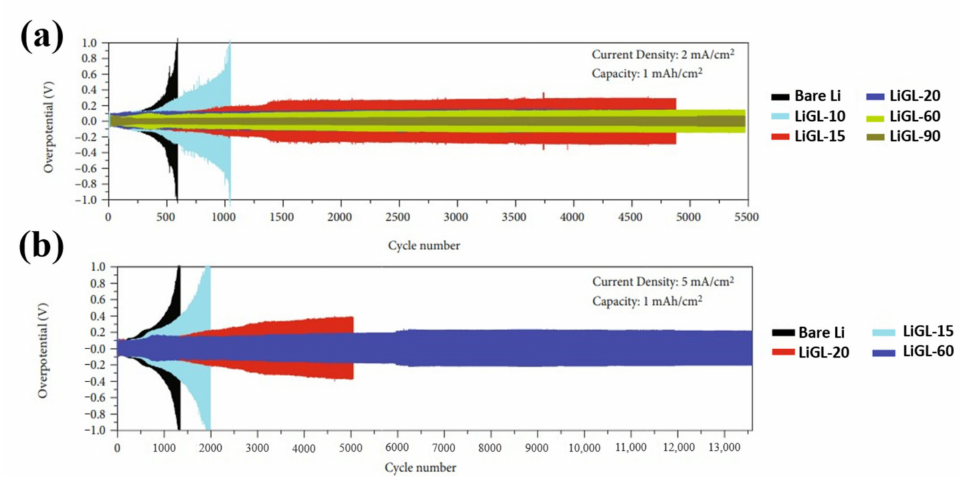
Figure 10. ( a ) Electrochemical stability of symmetric cells with bare and LiGL-coated Li in ether electrolyte at 2 mA cm − 2 and ( b ) 5 mA cm − 2 [57]. Reproduced with permis- sion [57]. Copyright 2021,